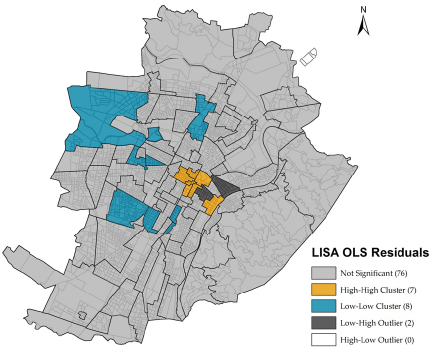
Figure 7. LISA (Cluster) maps depicting spatial clustering and spatial outliers of OLS residuals in the 93 HTUs of Turin. (Source: Authors’ elaboration).